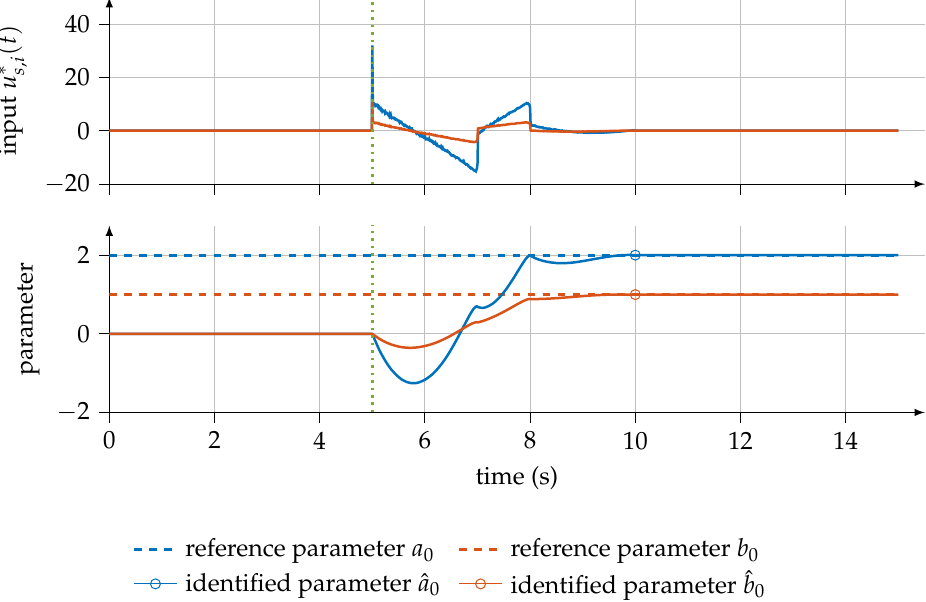
Figure 3. Parameter-specific control input and course of unknown parameter in the case of a noisy observation of the output